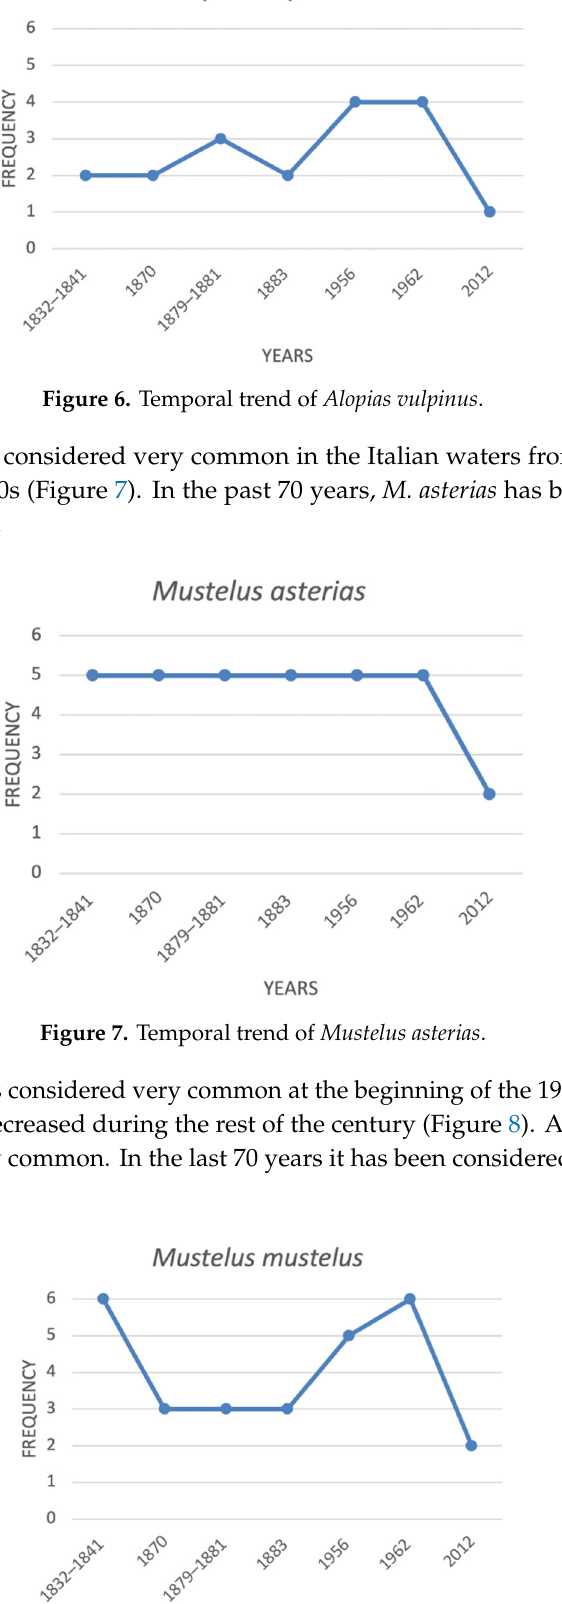
Figure 5. Temporal trend of Squatina squatina.